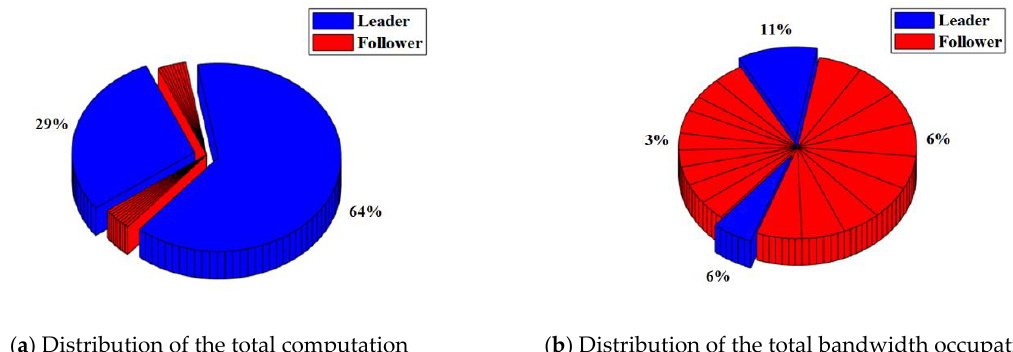
Figure 17. Resource occupation of the DDPOS algorithm with malicious nodes.